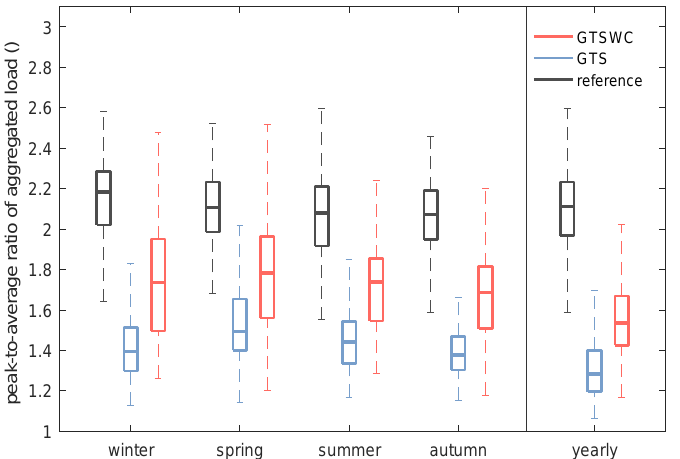
Figure 4. Peak-to-Average Ratio (PAR) of the aggregated load. A statistical analysis of the achieved daily PAR values over the respective seasons is shown. For each period, the reference case in which no storage is available is compared with a configuration that includes the optimally-sized batteries for each individual household for both the GTS and the GTSWC approaches.